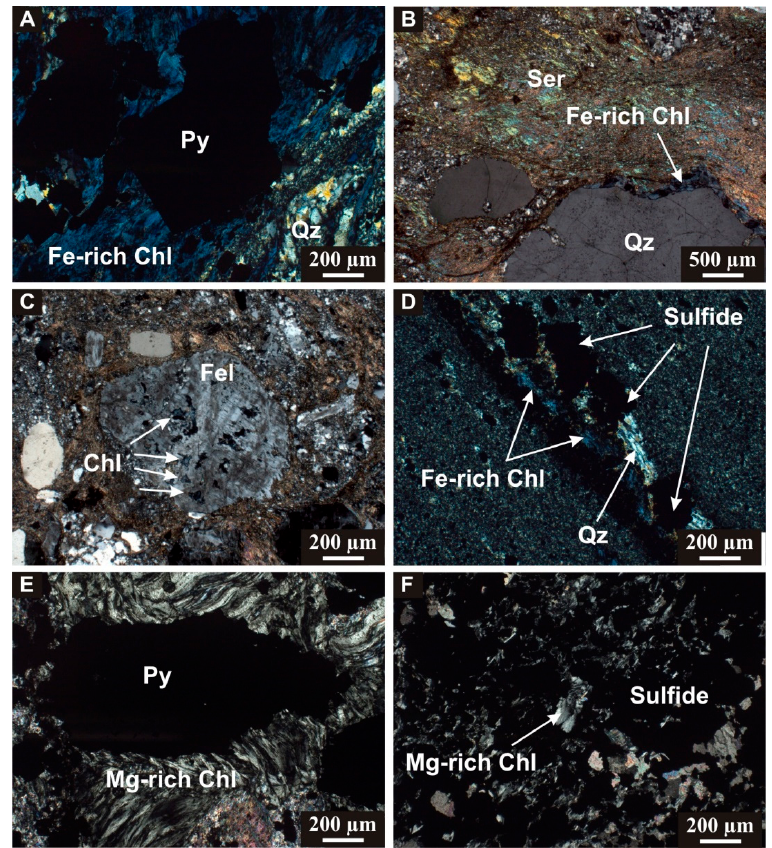
Figure 4. Photo-micrographs (crossed-polarized light) of chlorite varieties from the Bathurst Mining Camp (BMC). ( A ) Chlorite mass enclosing pyrite porphyroblast (A1-028 at 158 m). ( B ) Wispy chlorite surrounding quartz phenocryst in fine-grained groundmass of quartz and phyllosilicates (95-LPA-5 at 165 m). ( C ) Turbid K-Feldspar phenocryst hosting blebs of chlorite (see arrows) (95-LPA-8 at 219 m). ( D ) Sulfide–chlorite–quartz vein in very fine-grained matrix (A1-023 at 120 m). ( E ) Massive chlorite enveloping a pyrite grain (HN-99-119 at 1250 m). ( F ) Semi-massive sulfide sample, in which tension gashes are filled by chlorite, recrystallized quartz, carbonate mainly calcite, and subordinate white mica (94-DL-70 at 426 m).